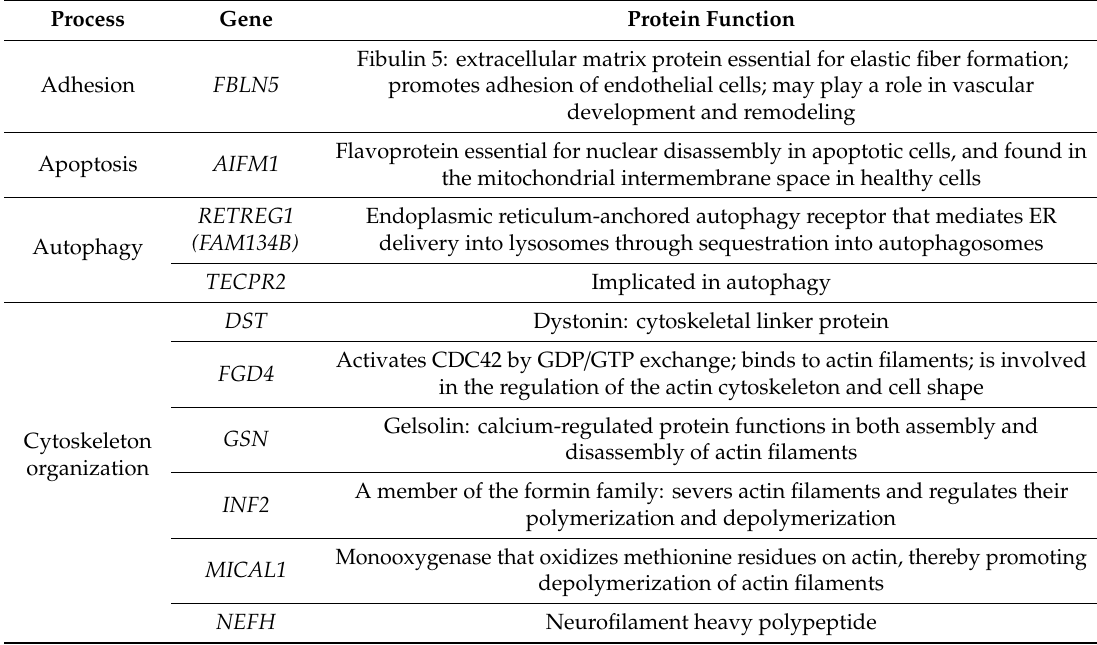
Table 2. Human Genes Associated with Neuropathies with No Yeast